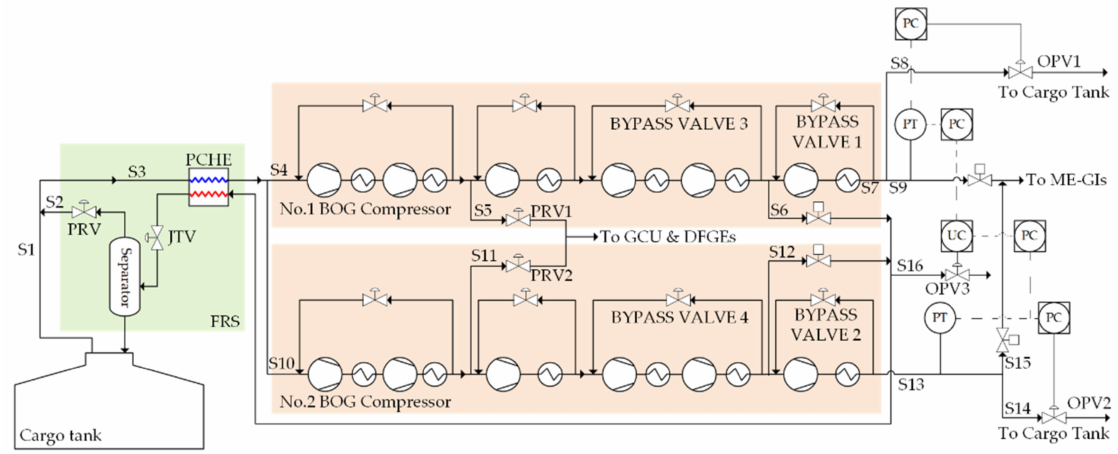
Figure 4. Configuration of a novel fuel gas supply system with a full re-liquefaction system (Case